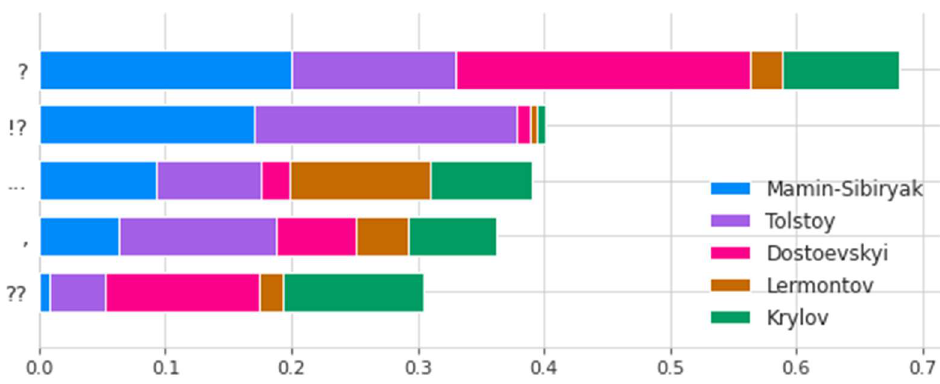
Figure 11. Top five informative features based on RbFS decision.